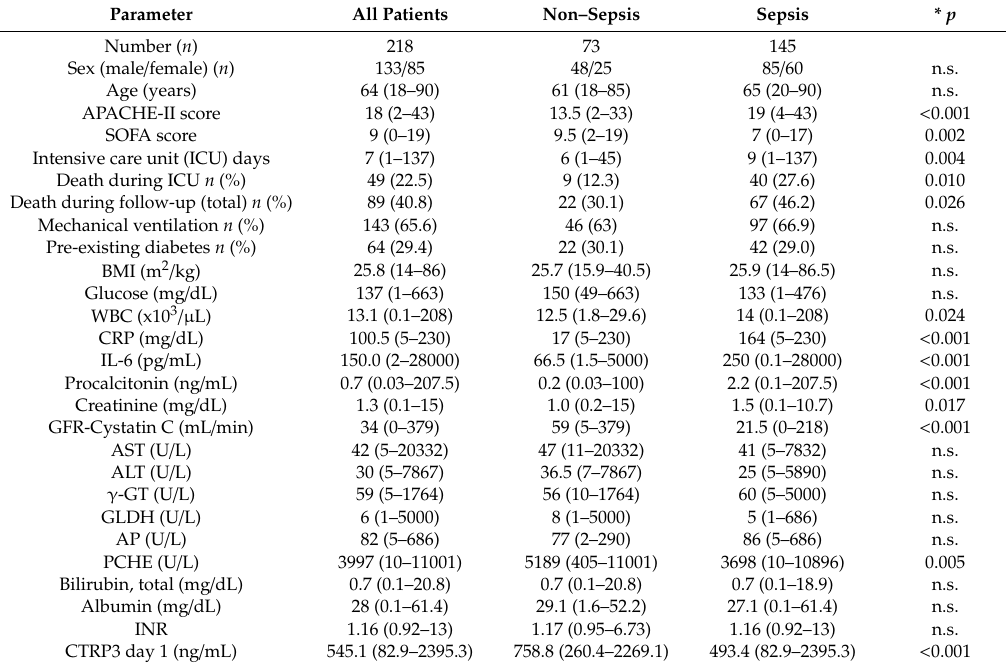
Table 1. Baseline patient characteristics and C1q / tumor necrosis factor (TNF)-like protein 3 (CTRP3) plasma